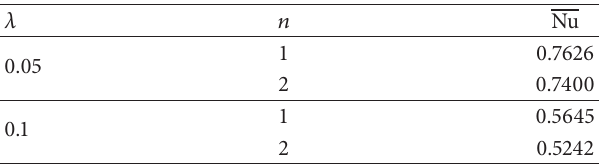
Table 1: Average Nusselt number of bottom wall for 𝜆 = 0.05, 0.1 and 𝑛 = 1,